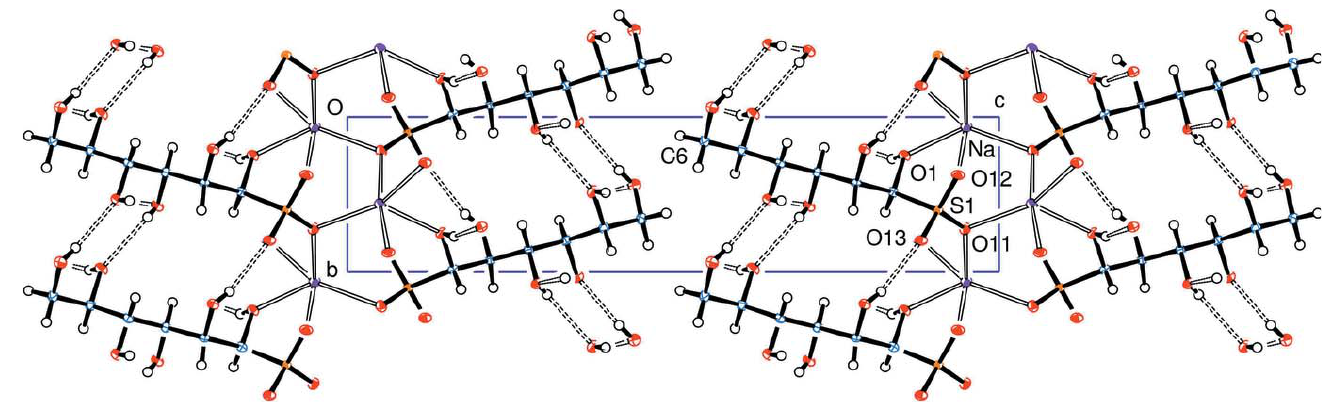
Figure 2 View down the a axis of the crystal packing.